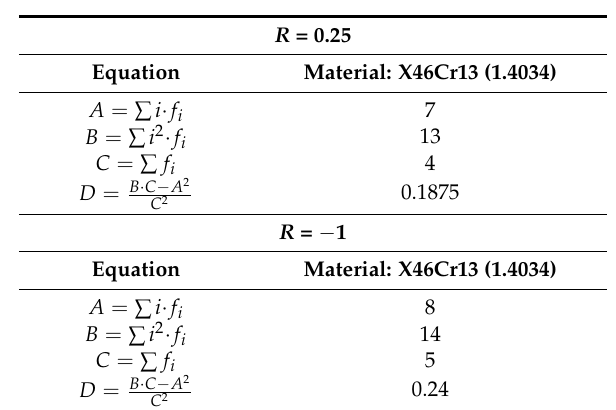
Table 6. A , B , C and D constants calculated in accordance with the ISO